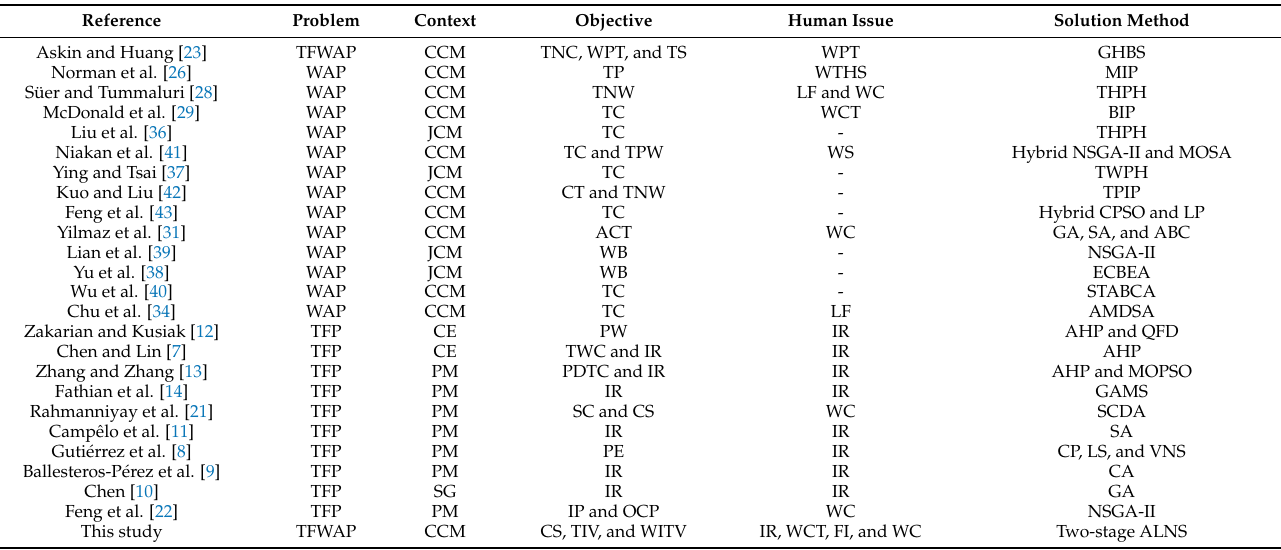
Table 1. Summary of previous